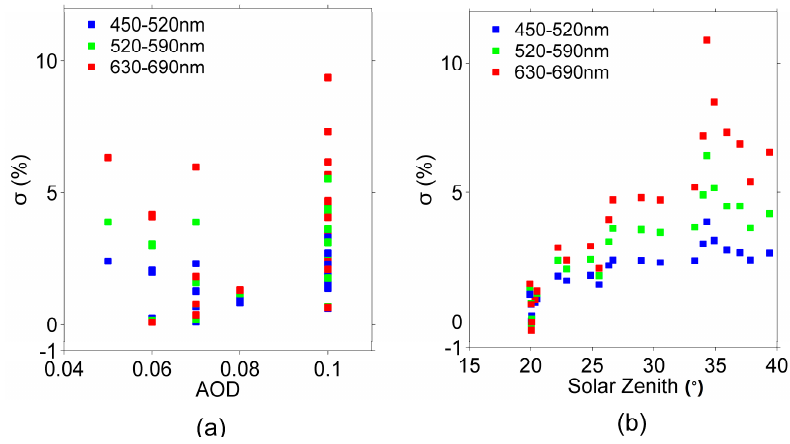
Figure 7. σ i (%, coefficient uncertainty with Aerosol Optical Depth (AOD) changes ± (5%AOD + 0.03)) of 22 examples versus: ( a ) AOD and ( b ) solar zenith angle (marked color represents different bands: 450–520 nm (blue), 520–570 nm (green), and 630–690 nm (red)).